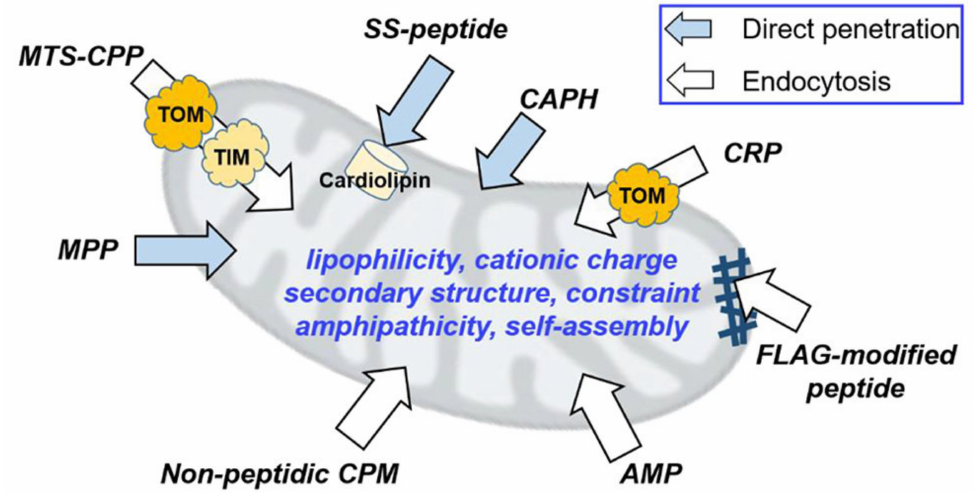
Figure 7. Mitochondrion-targeting peptides and peptidomimetics based on their structural classes and reported applications. Abbreviations: MTSCPP, MTS with cell-penetrating peptides; MPP, mitochondrion-penetrating peptides; SS-peptides, Szeto − Schiller peptides; CAPH, cationic am- phiphilic polyproline helix; CRP, cysteine-rich peptides; FLAG-modified peptide, FLAG tag-based peptide that self-assembled into a nanofiber; AMP, peptides derived from antimicrobial peptides; CPM, nonpeptidic cell-penetrating motif; OMM, outer mitochondrial membrane; IMM, inner mito- chondrial membrane; IMS, intermembrane space. Reprinted with modification from [233].